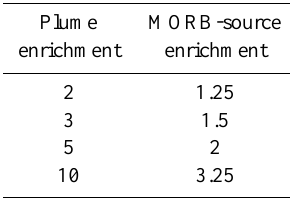
Table 3. Enrichments of plume components. Table 4. MORB-source enrichments due to plume